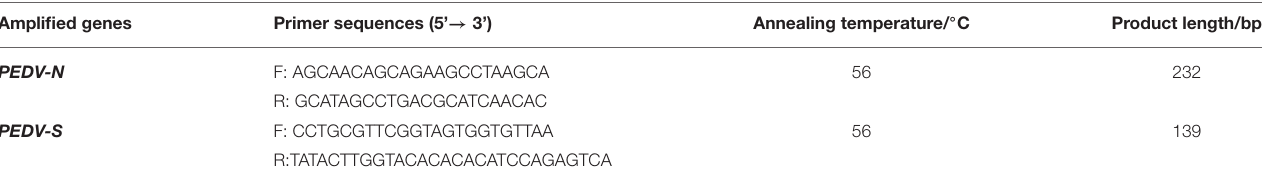
TABLE 1 | Primer. Amplified